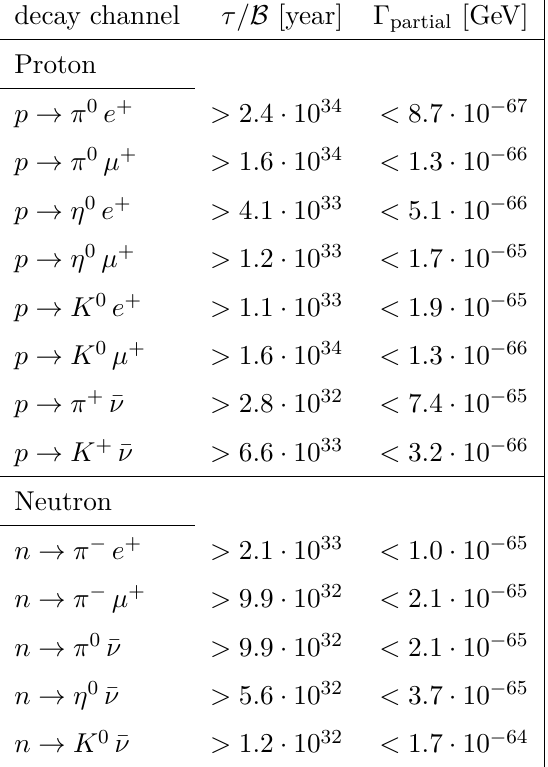
Table 2 . The 90 % confidence level exclusion bounds on proton and neutron decay from the Super- Kamiokande experiment for various ( B − L )-preserving decay channels with a meson and a lepton in the final state. For each decay channel the corresponding lifetime bound τ/ B and the translated partial decay width Γ are listed, where B is the branching ratio for the decay channel. The partial data is taken from figure 5 - 3 in [38] and further updated with other sources [8,